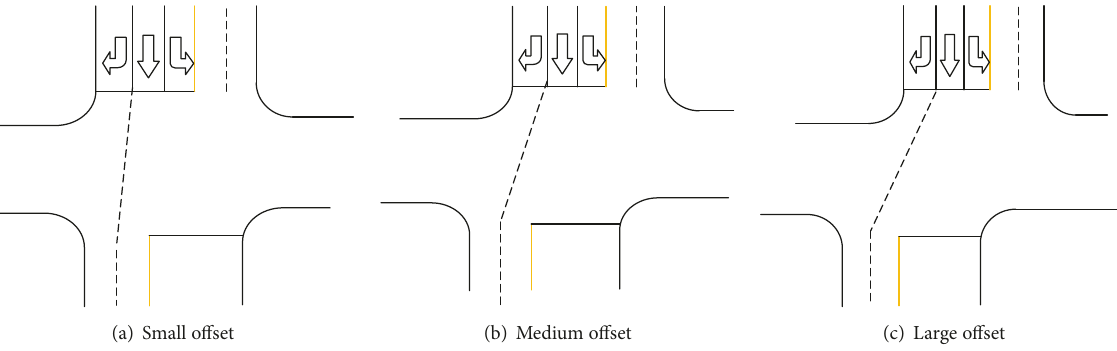
Figure 2: Through movement offset categories.